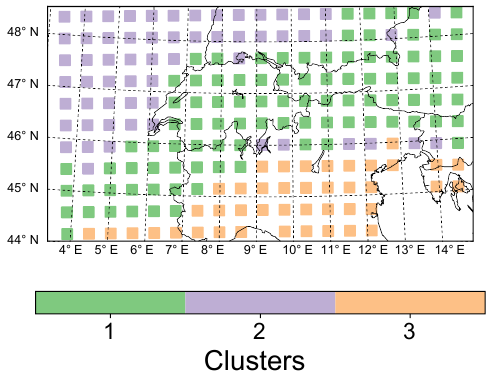
Figure B1. Illustration of the effect of α and C 1 on randomly gener- ated fields. Blue pixels correspond to zero intensity, whereas pixels with non-zero intensity are shown with a grayscale colormap. Taken from Lovejoy (2017).